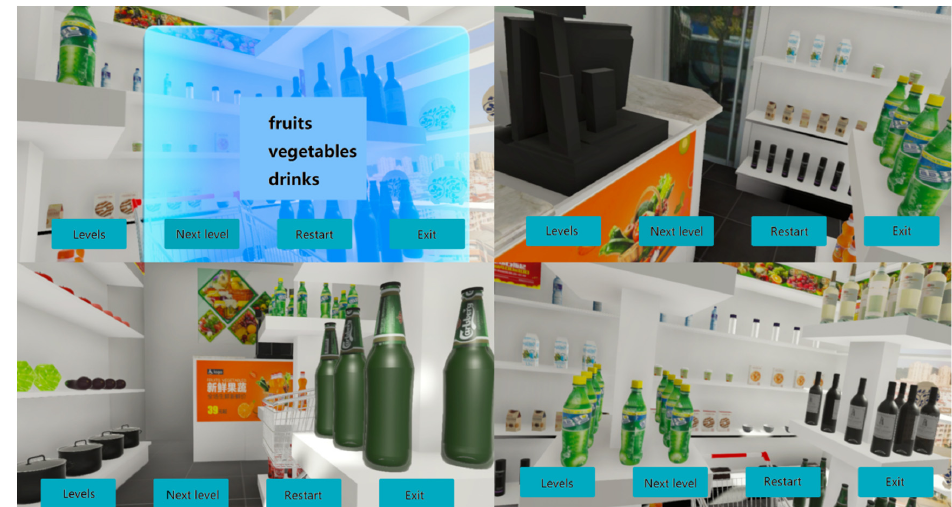
Figure 1. Participant perspective of the virtual reality supermarket.